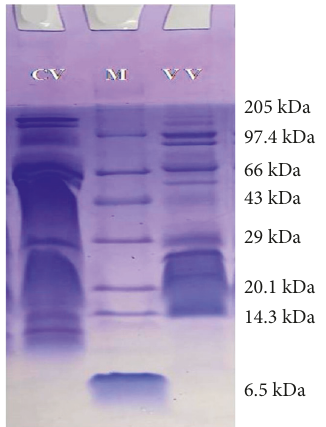
Figure 4: Separation and visualization of proteins bands of venom samples in 12% SDS-PAGE (M, marker protein; CV, cobra venom; VV, viper